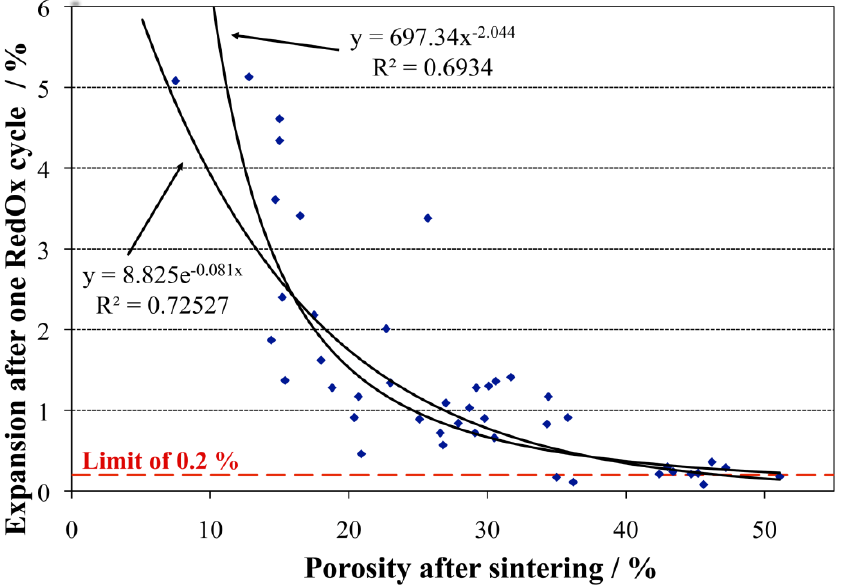
Figure 30. Expansion after one RedOx cycle at 800 °C versus porosity of 46 NiO-8YSZ anode-support samples